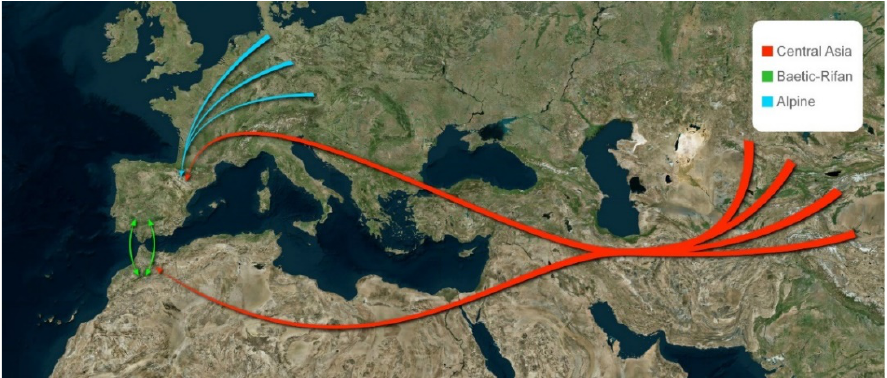
Figure 9. Suggested dispersal routes affecting the myrmecofauna of the IP. (Base map obtained from https://laboratoriorediam.cica.es/VisorRediam/ (Accessed on 2 December 2020)). Junta de Andalucía. Consejería de Agricultura, Ganadería, Pesca y Desarrollo Sostenible (ámbito de Desarrollo Sostenible).